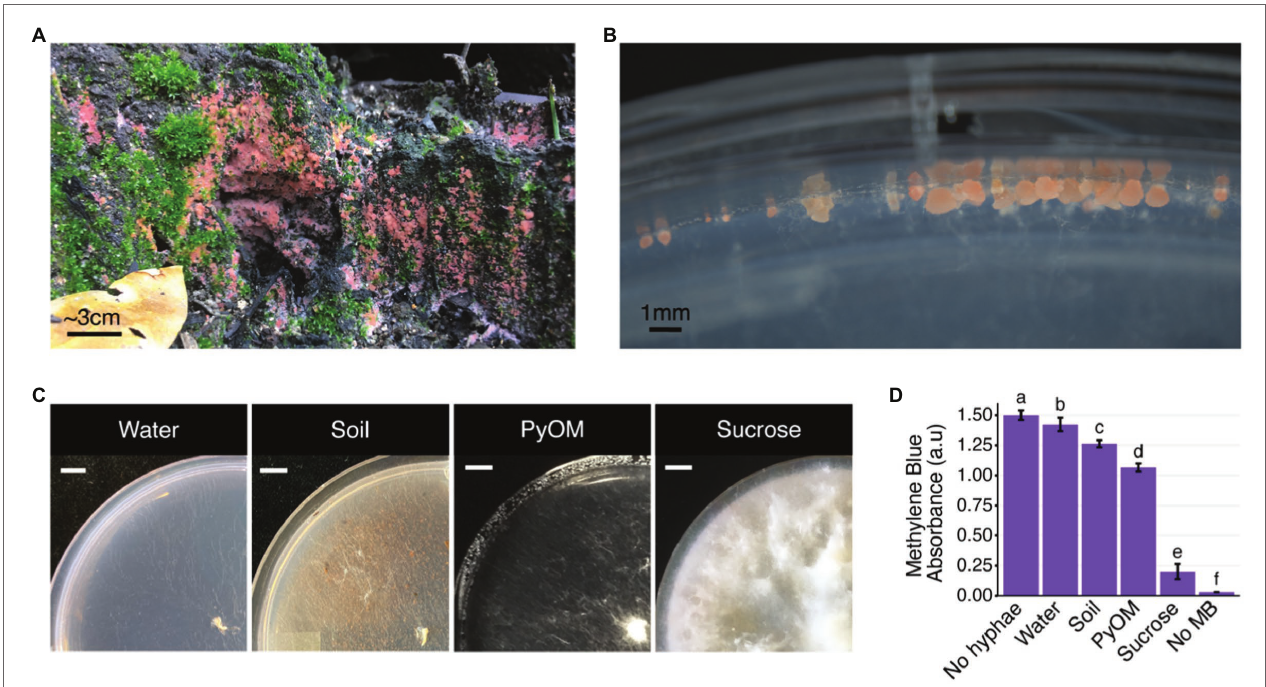
FIGURE 1 | Pyronema growth on natural and laboratory substrates. (A) Pyronema sp. fruiting on burned soil 6 months after the 2018 Camp Fire began near Paradise, California, United States. (B) Pyronema domesticum DOB7353 ascocarps on the edge of a water agar plate. (C) Pyronema domesticum DOB7353 growing on four different agar media treatments: water agar with no added nutrients (“Water”), wildfire-burned soil collected near the original isolation site for P. domesticum DOB7353 (“Soil”), 750 ° C White Pine wood char [“pyrolyzed organic matter (PyOM)”], or Vogel’s minimal medium with sucrose as a carbon source (“Sucrose”). All plates were inoculated in the center of the plate (bottom-right corner of photo) with mycelium from a 6-mm-diameter punch of an actively growing P. domesticum colony. Scale bar = 1 cm. (D) Average amount of P. domesticum DOB7353 biomass on one full plate as show in (C) , quantified by measuring the amount of Methylene Blue (MB) stain remaining after absorption by P. domesticum hyphae. All treatments are significantly different from each other, lowercase letters above each bar indicate significantly different groups (ANOVA+Tukey’s test, p < 0.0001, n = 5, error bars = SD). The “No hyphae” control is pure 0.2 mM MB without any biomass treatment. The “No MB” control is a blank